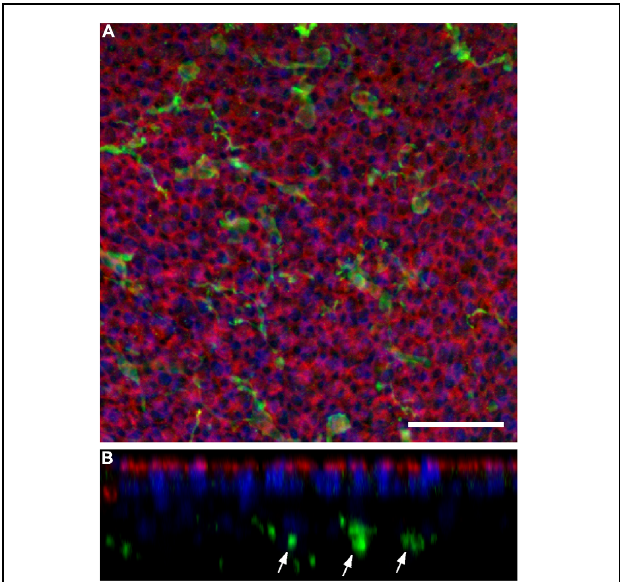
FIGURE 3 | Normal utricles contain resident populations of macrophages, which are primarily confined to the stromal tissue below the sensory epithelium. (A) Maximum intensity projection of a confocal stack collected from the central region of a histologically processed mouse utricle, to a depth of 20 µ m. (B) Computationally reconstructed ‘z-slice,’ showing a slide view of the same image. Cell-cell junctions are labeled with phalloidin (red) and cell nuclei are stained with DAPI (blue). In addition, GFP-expressing macrophages (green) appear distributed throughout the specimen. However, examination of z-slice images reveals that nearly all macrophages reside in the stromal tissue, below the sensory epithelium (arrows). Scale bar = 30 µ m.